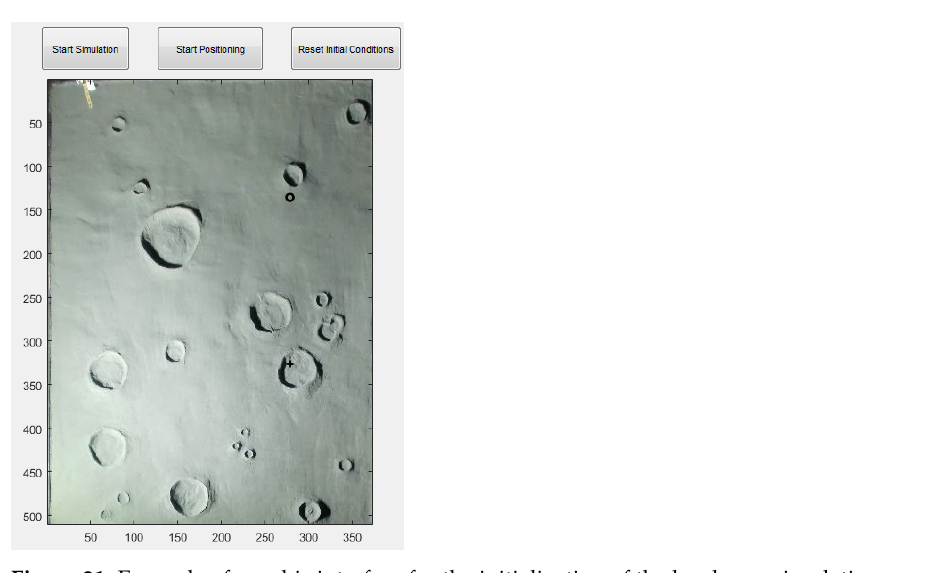
Figure 21. Example of graphic interface for the initialization of the hardware simulation.